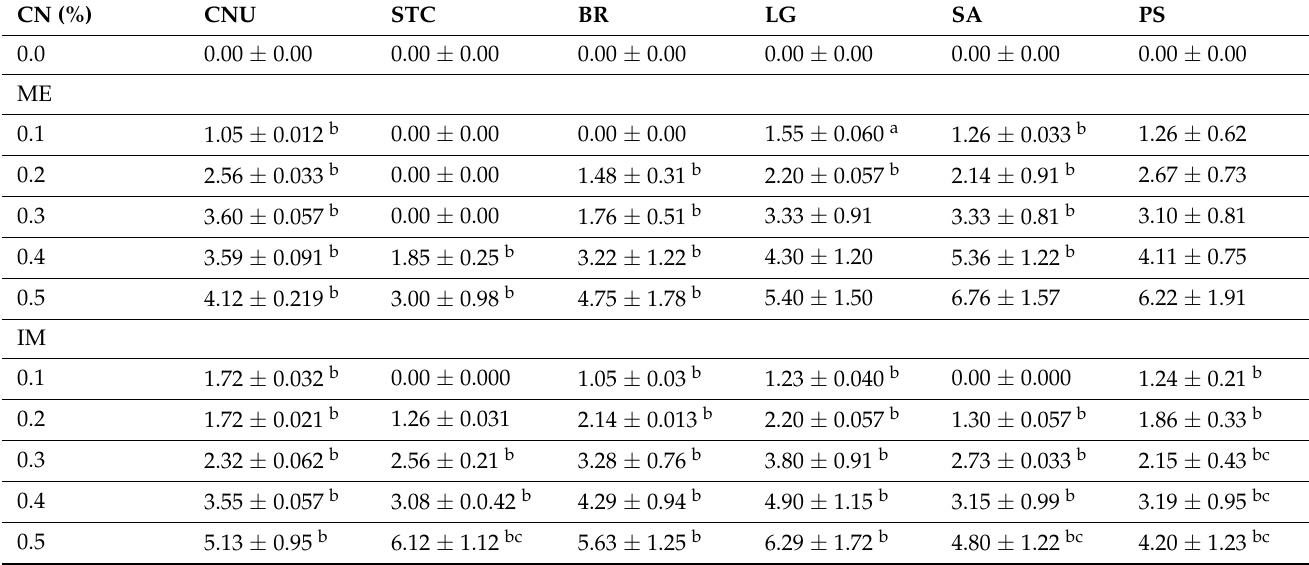
Table 5. Percentage of meiotic abnormality in metaphases I and II and anaphases I and II of plates of P. sativum in PMCS exposed to different concentrations of ME and IM for 3